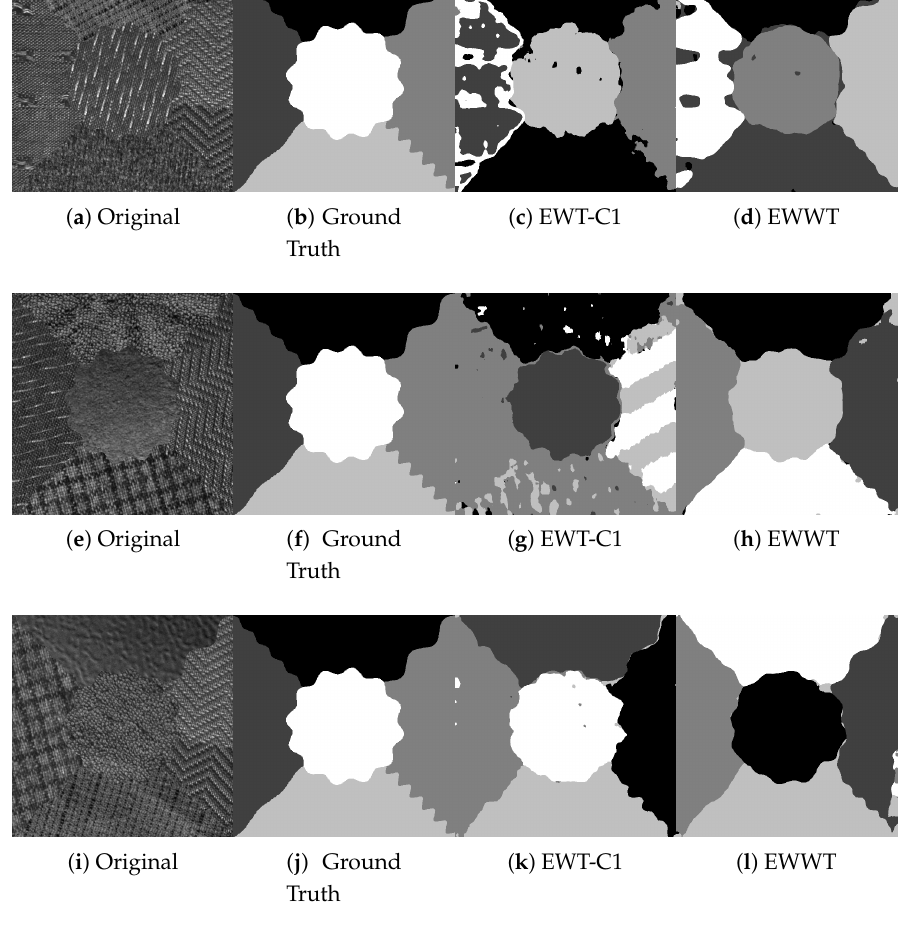
Figure 8. Results of Segmentation performed on Outex using empirical curvelets (EWT-C1) and empirical watershed wavelets